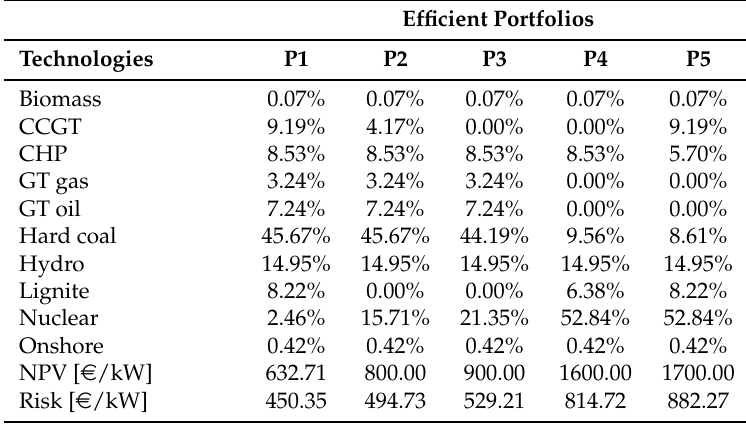
Table A3. Efficient portfolios according to FSMAD Model 2 for existing